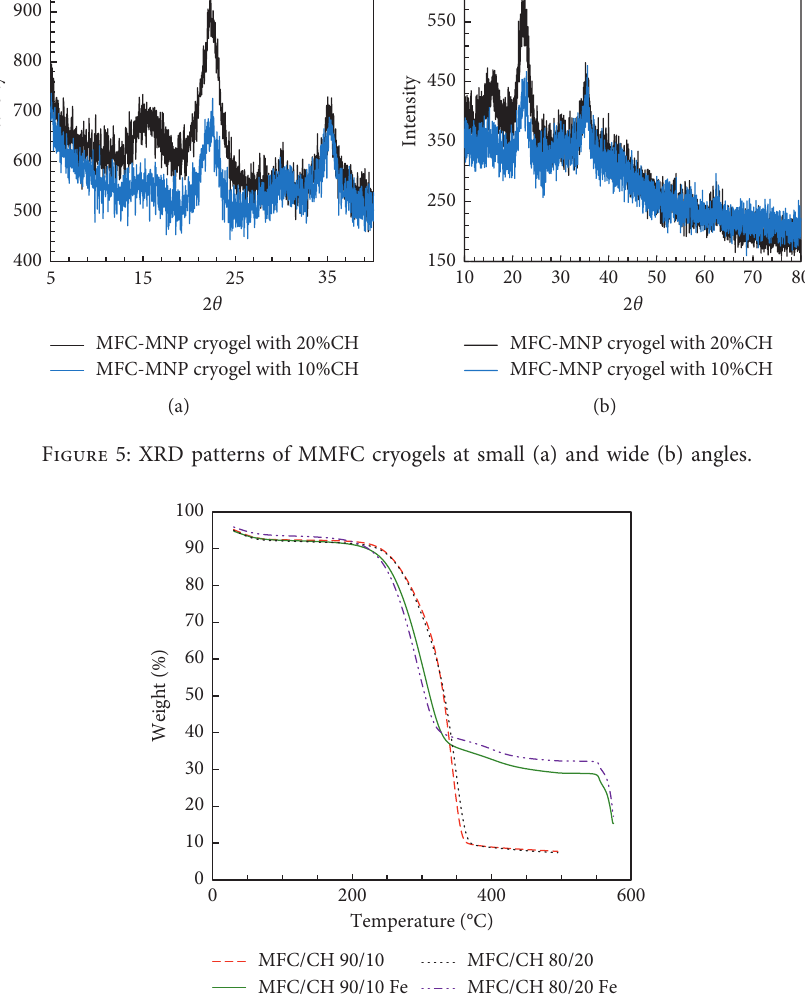
° C andthenunder oxygenuntil575 ° C). 2 atmosphereuntil 500